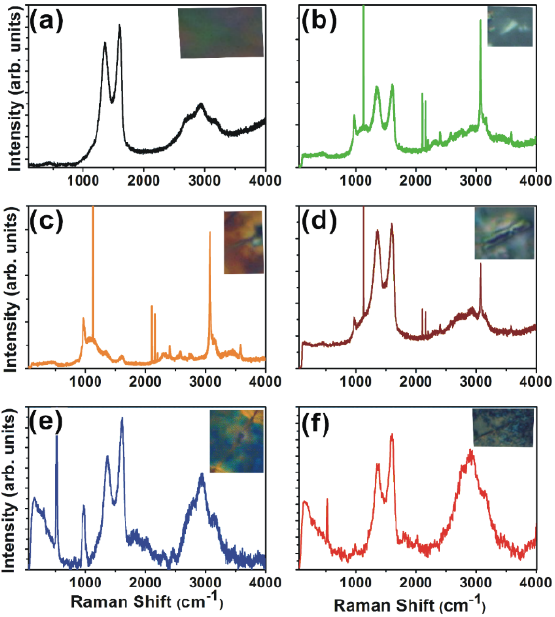
Figure 3. Raman spectra of ( a ) GO; ( b – f ) different regions of GNP1 film. The corresponding optical images are shown in the inset of each figure.